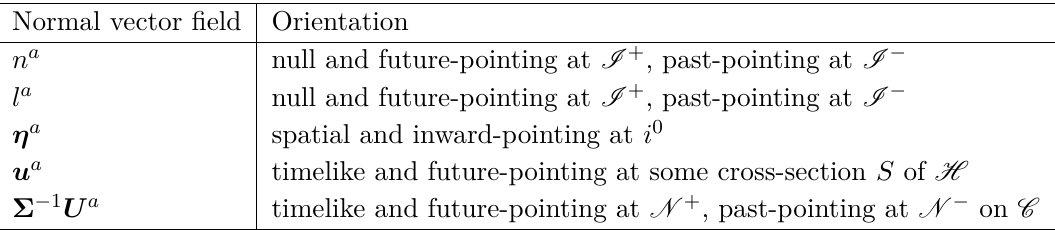
Table 1 . Conventions for orientation of